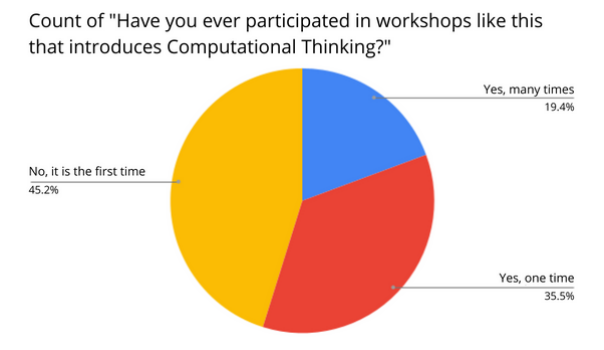
Figure 5. Graph of the responses from the Computational Thinking workshop to the question “Have you ever participated in workshops like this that introduces Computational Thinking?”.